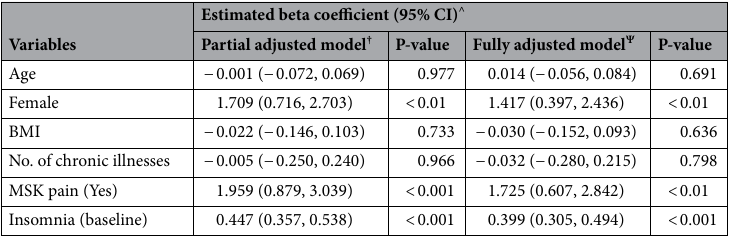
Table 2. Association of the predictive factors and insomnia at 18 months (n = 498). ^ Abbreviations: CI, confidence interval; MSK: Musculoskeletal; BMI: Body Mass Index; † Adjusting for insomnia at baseline except for the model of insomnia at baseline on insomnia at 3 years; Ψ Adjusting for age, gender, BMI, and no. of comorbid diseases.